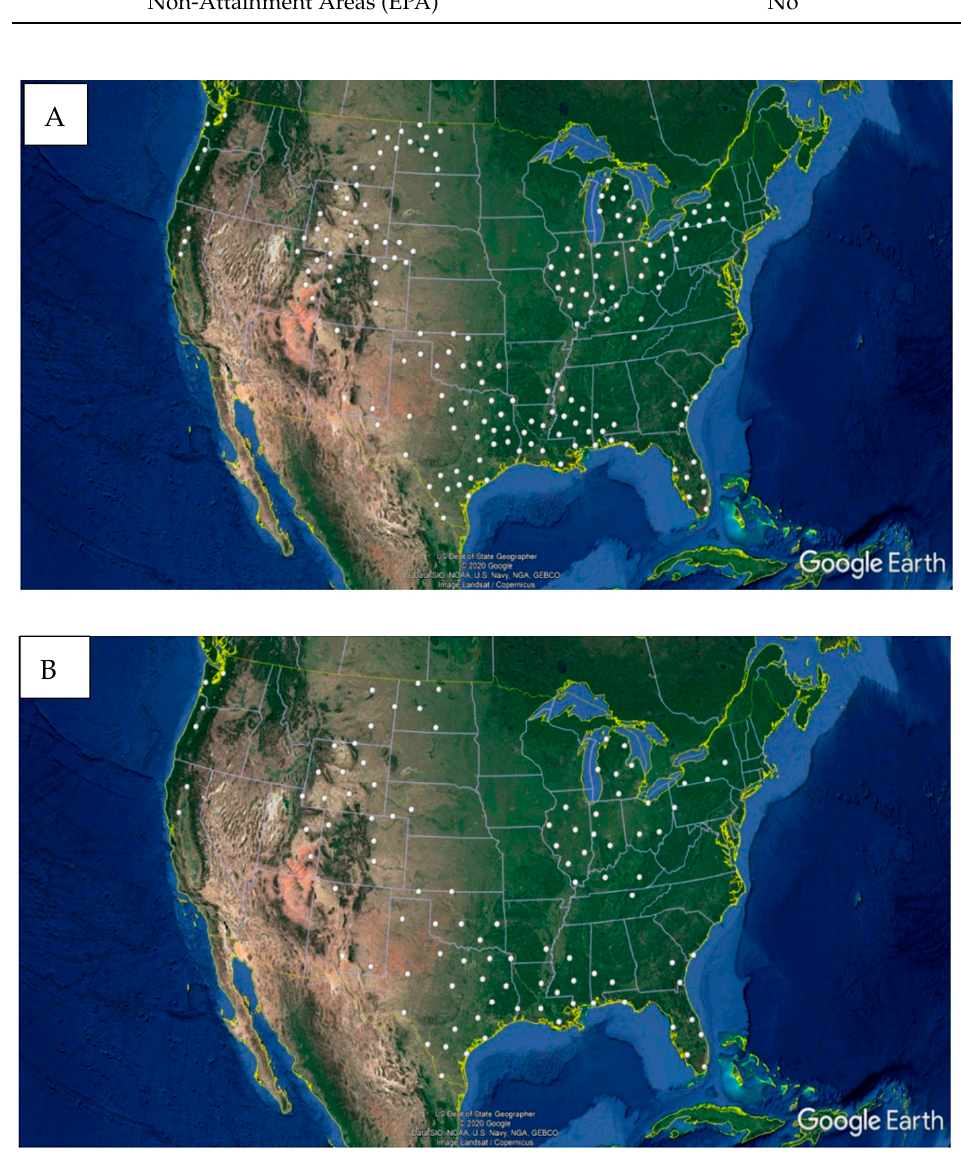
Figure A1. ( A ) Potential sites thinned to a distance of 80 km (171 sites). ( B ) Potential sites thinned to a distance of 121 km (103 sites) [11].